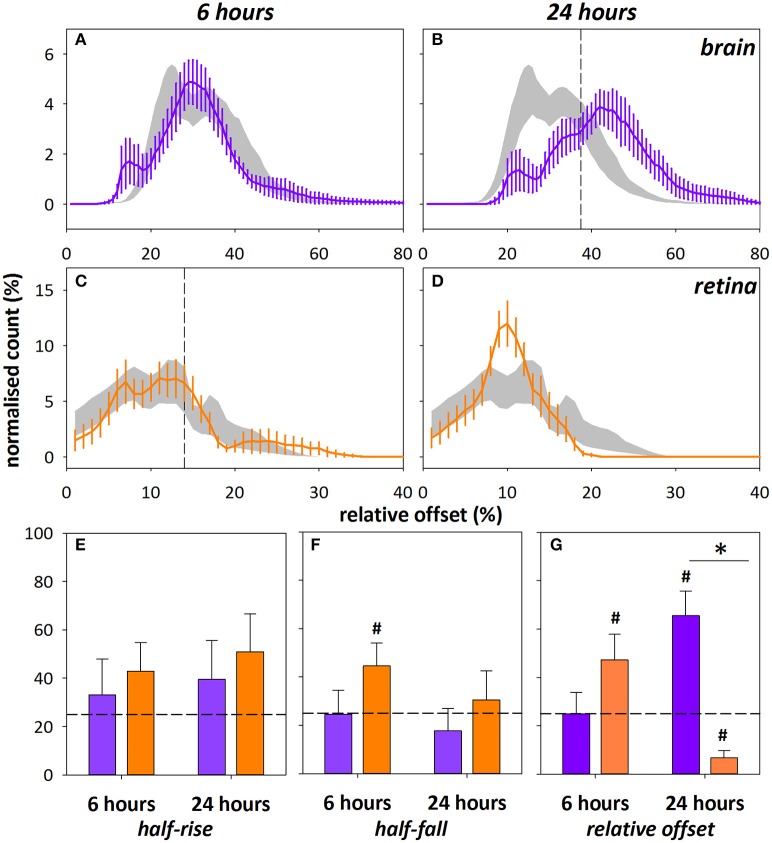
Frequency histograms for relative offset at 6 and 24 h after DOC administration in cortical (A,B, purple) and retinal (C,D, orange) capillaries/extravascular space. Saline control ± SEM shown in gray, vertical dashed line indicates 75% cut-off determined from the saline control group. Note the different scales for offset between brain and retina. The index of injury (number of pixels above 75% cut-off, %) for the half-rise (E), half-fall (F), and relative offset (G) at 6 and 24 h after DOC injury. Data shown for capillaries only, arteries and veins were similarly altered (Figure S3). *Indicates significant difference between groups at 24 h time point, p < 0.001, Mann–Whitney test.#Denotes indices >±2 SEM from 25% (horizontal dashed line).